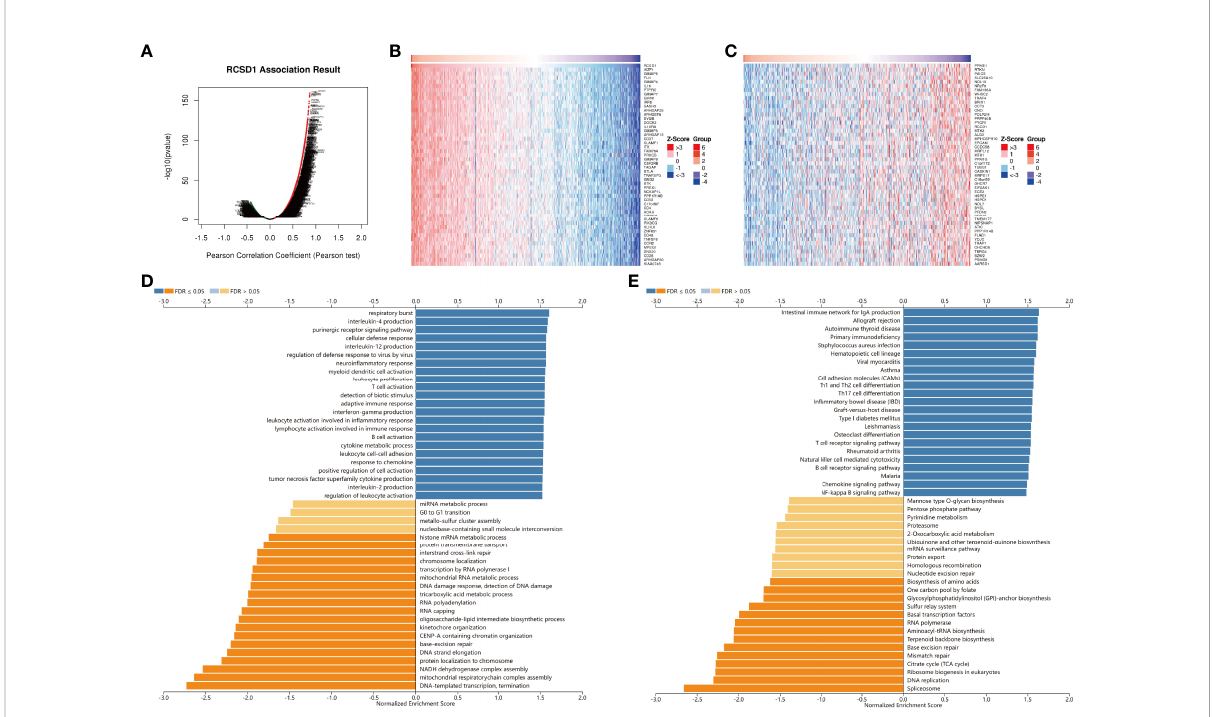
FIGURE 8 Co-expression genes and enrichment analysis of RCSD1 in LUAD. (A) The whole signi fi cantly associated genes with RCSD1 distinguished by Pearson test in LUAD cohort. (B) Top 50 positive co-expression genes of RCSD1. (C) Top 50 negative co-expression genes of RCSD1. (D) GO annotations in LUAD. (E) KEGG pathways in